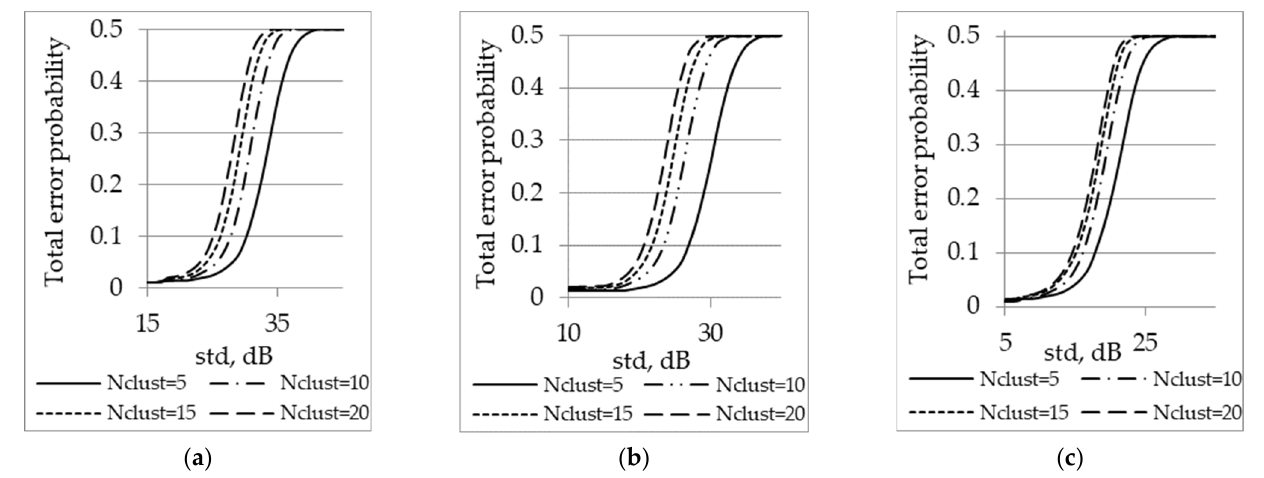
Figure 19. Minimum values of the total error probability of a fatigue crack detection against the background of stationary uncorrelated ( a ), stationary correlated ( b ) and nonstationary frictional ( c ) noise.